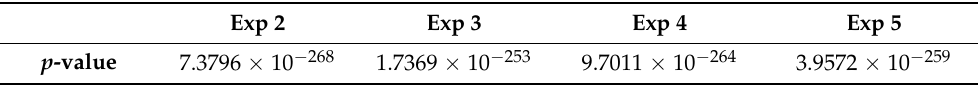
Table 8. Ensemble models’ lowest errors statistical significance